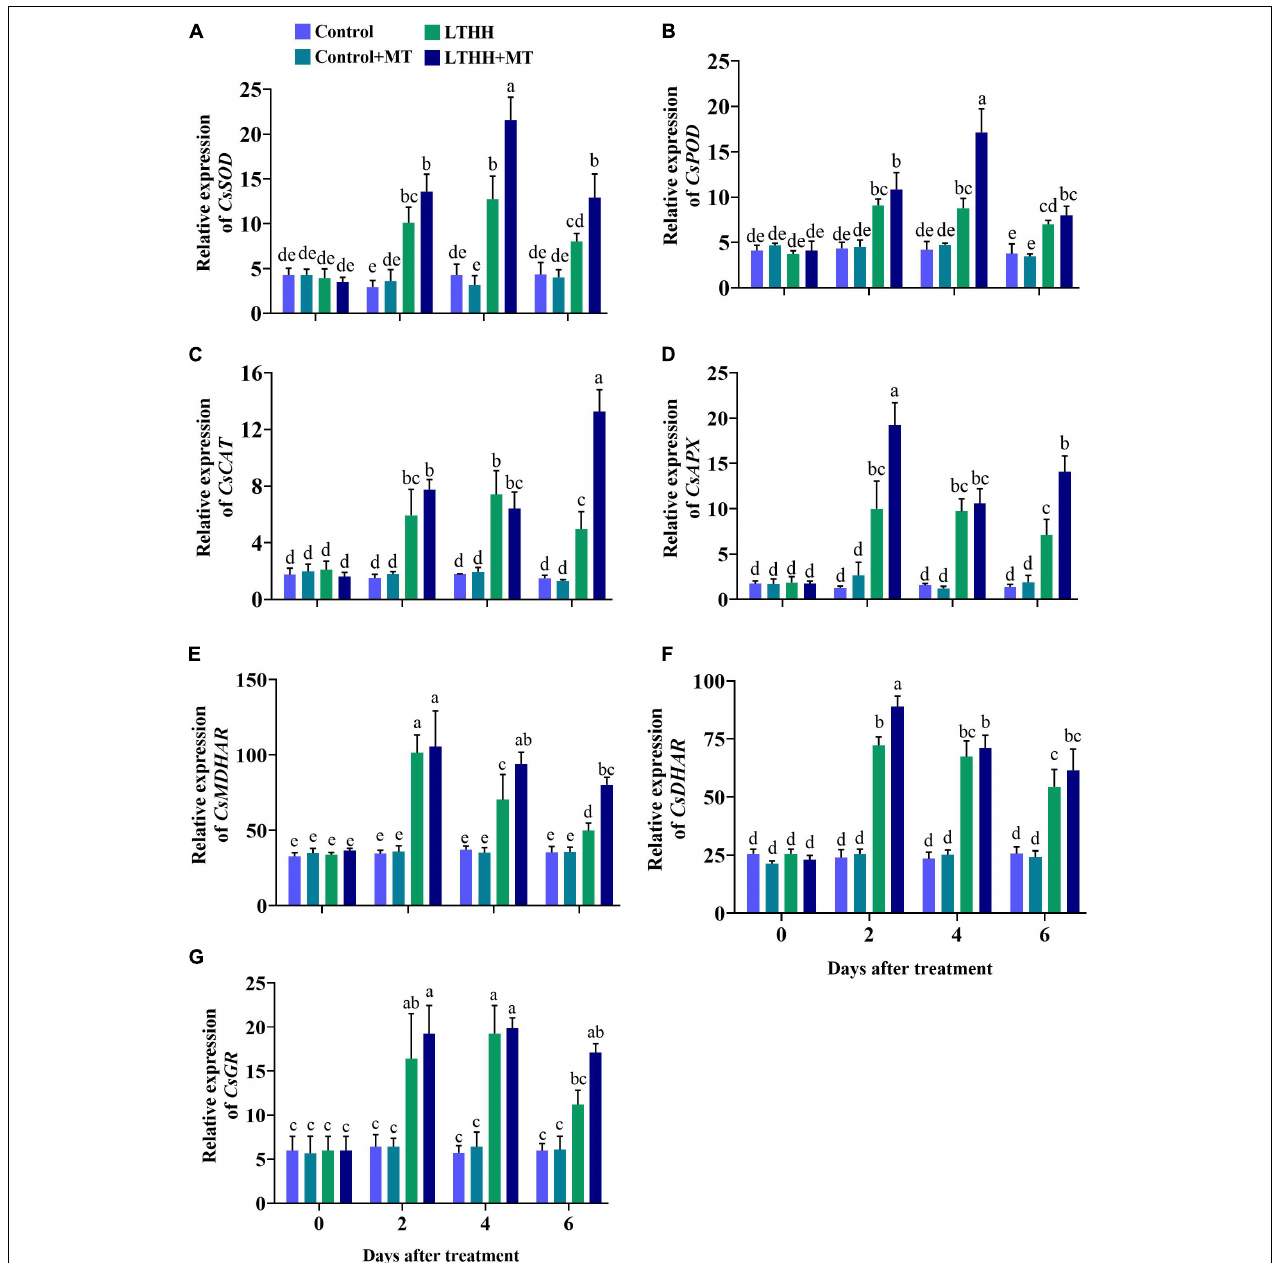
FIGURE 4 | Effect of exogenous melatonin on relative expression of SOD (A) , POD (B) , CAT (C) , APX (D) , MDHAR (E) , DHAR (F) , and GR (G) in cucumber seedling under low-temperature and high-humidity stress. Control (25/18 ◦ C); Control + MT (200 µ M melatonin, 25/18 ◦ C); LTHH (15/10 ◦ C, 95%); LTHH + MT (200 µ M melatonin, 15/10 ◦ C, 95%). Same letters on the bars represent no significant differences, while different letters represent significant differences among treatments ( P > 0.05 was non-significant). Data are means ± SD of three replicates ( n =